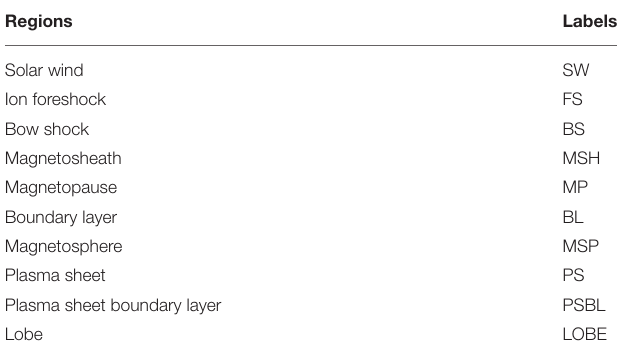
TABLE 1 | Labels for the 10 different near-Earth regions in our model.